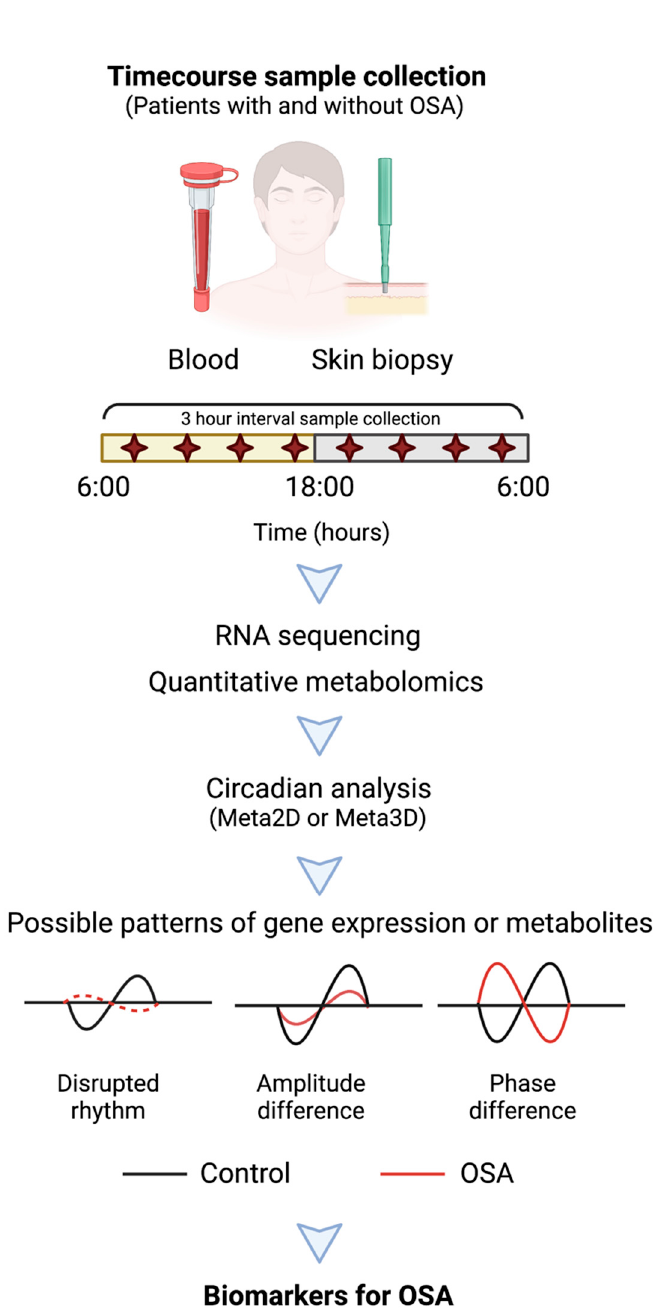
Figure 1. A study design for developing circadian biomarkers in patients with OSA. Blood or skin samples should be collected over a period of 24 h from patients with and without OSA. Extracted RNA or metabolites further processed for RNA sequencing or quantitative metabolomics. Analytical tools such as MetaCycle (Meta2D and 3D) should be used to detect rhythms of transcriptome or metabolites among patients with and without OSA. Genes or metabolites with amplitude or phase differences among healthy controls vs. patients with OSA may be used as potential biomarkers for OSA diagnosis and treatment. This figure was created with BioRender.com.